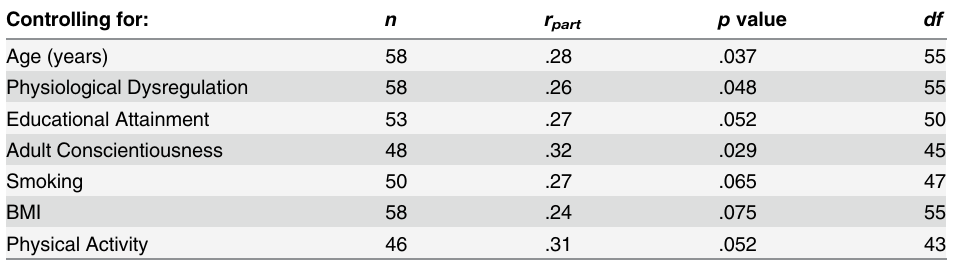
Table 3. Partial biserial correlations between child conscientiousness and LTL controlling separately for age, physiological dysregulation, educational attainment, and adult conscientiousness, smoking, BMI, and physical